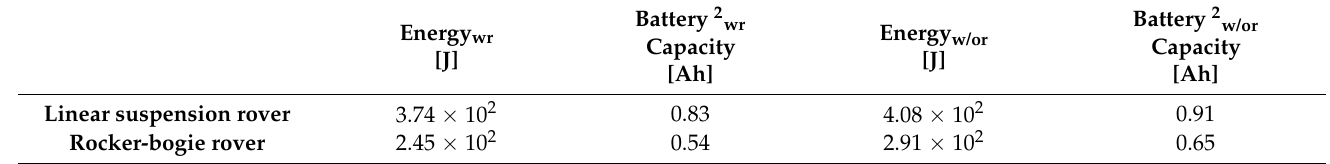
Figure 11. Absorbed power on the motor of each wheel: ( a ) linear suspension rover; ( b ) rocker- bogie rover. Table 5. Energy 1